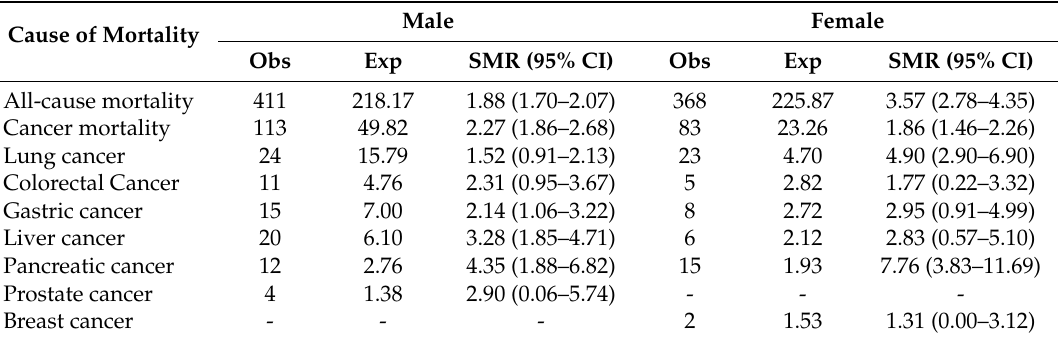
Table 5. Standardized mortality ratios in patients with type 2